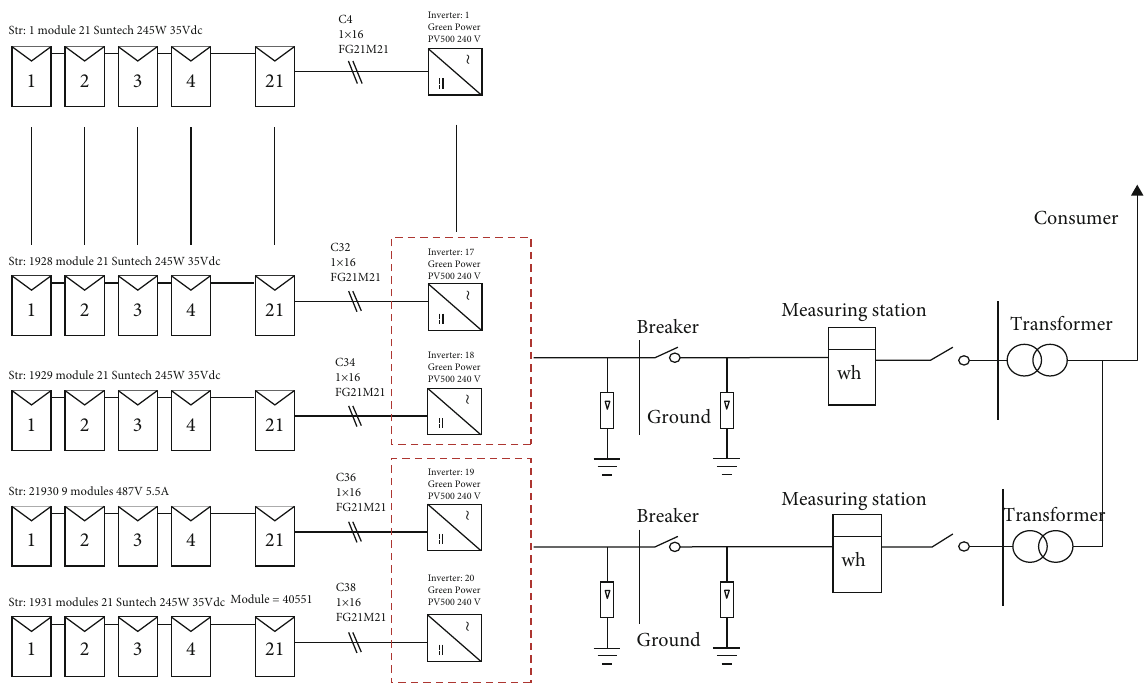
Figure 15: Electrical diagram of the studied PV Table 4: Meteorological parameters for Grojdibodu location.